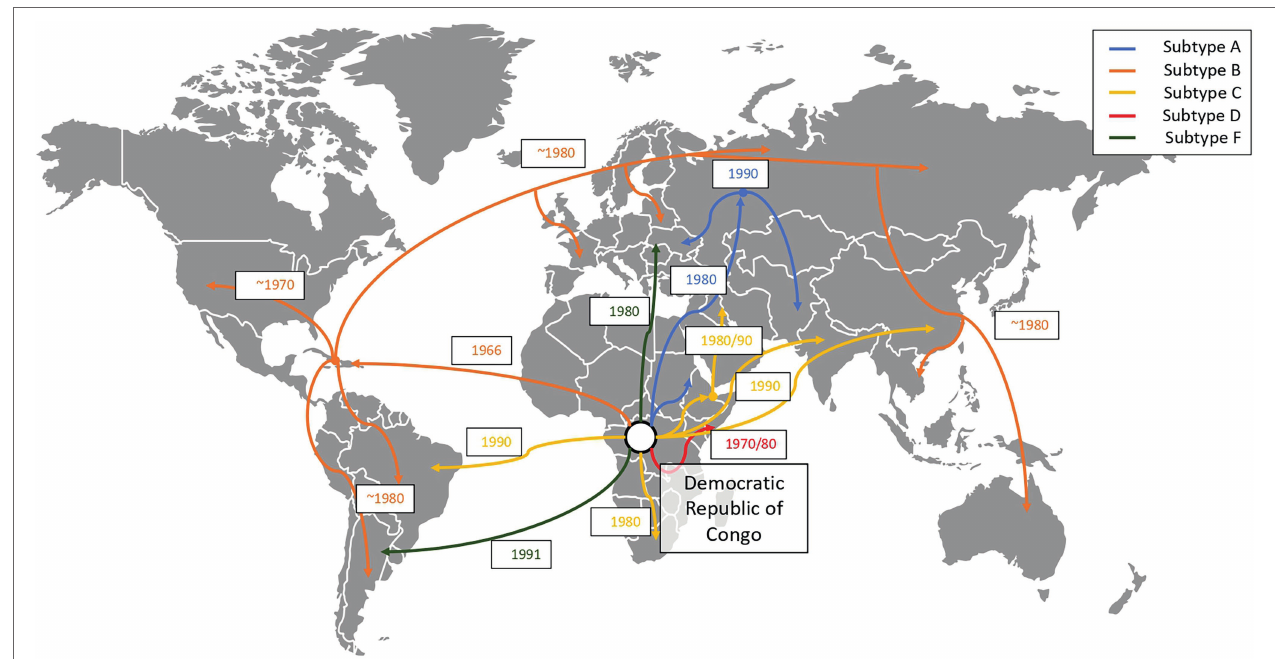
FIGURE 5 | Global evolution and chronology of events of spread of the HIV-1 group M subtypes (Tebit and Arts, 2011). We show how HIV-1 group M disseminated from its original epidemic location (Kinshasa, Democratic Republic of Congo) to other regions of the globe. The figure depicts how subtype B is the most widely spread subtype, subtype A spread mostly to the east regions of Africa, Europe and Asia and subtype C spread mostly through Brazil, South Africa and Southeast